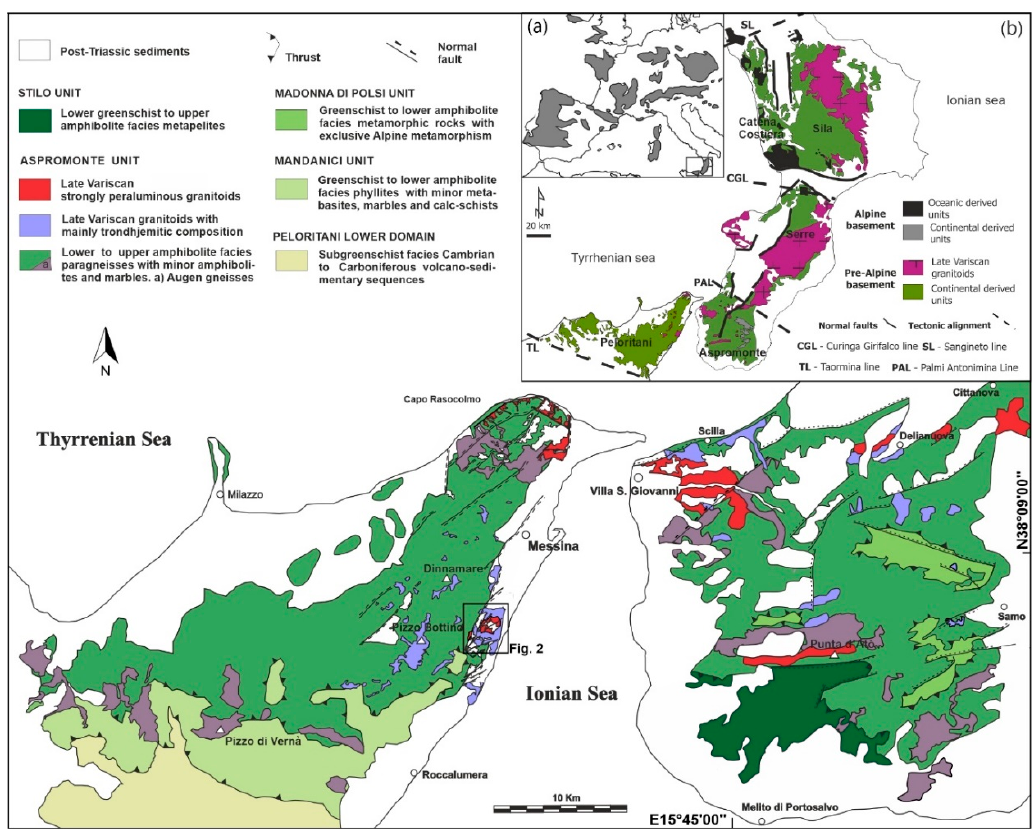
Figure 1. Geological sketch map of the northeastern Peloritani Mountains and western Aspromonte Massif with distribution of the late-Variscan granitoids (after [47]; and references therein). Insets show ( a ) distribution of pre-Alpine basements in western Europe and ( b ) distribution of Alpine and pre-Alpine basement rocks in the Calabria–Peloritani Orogen and main tectonic alignments (modified after [42]).